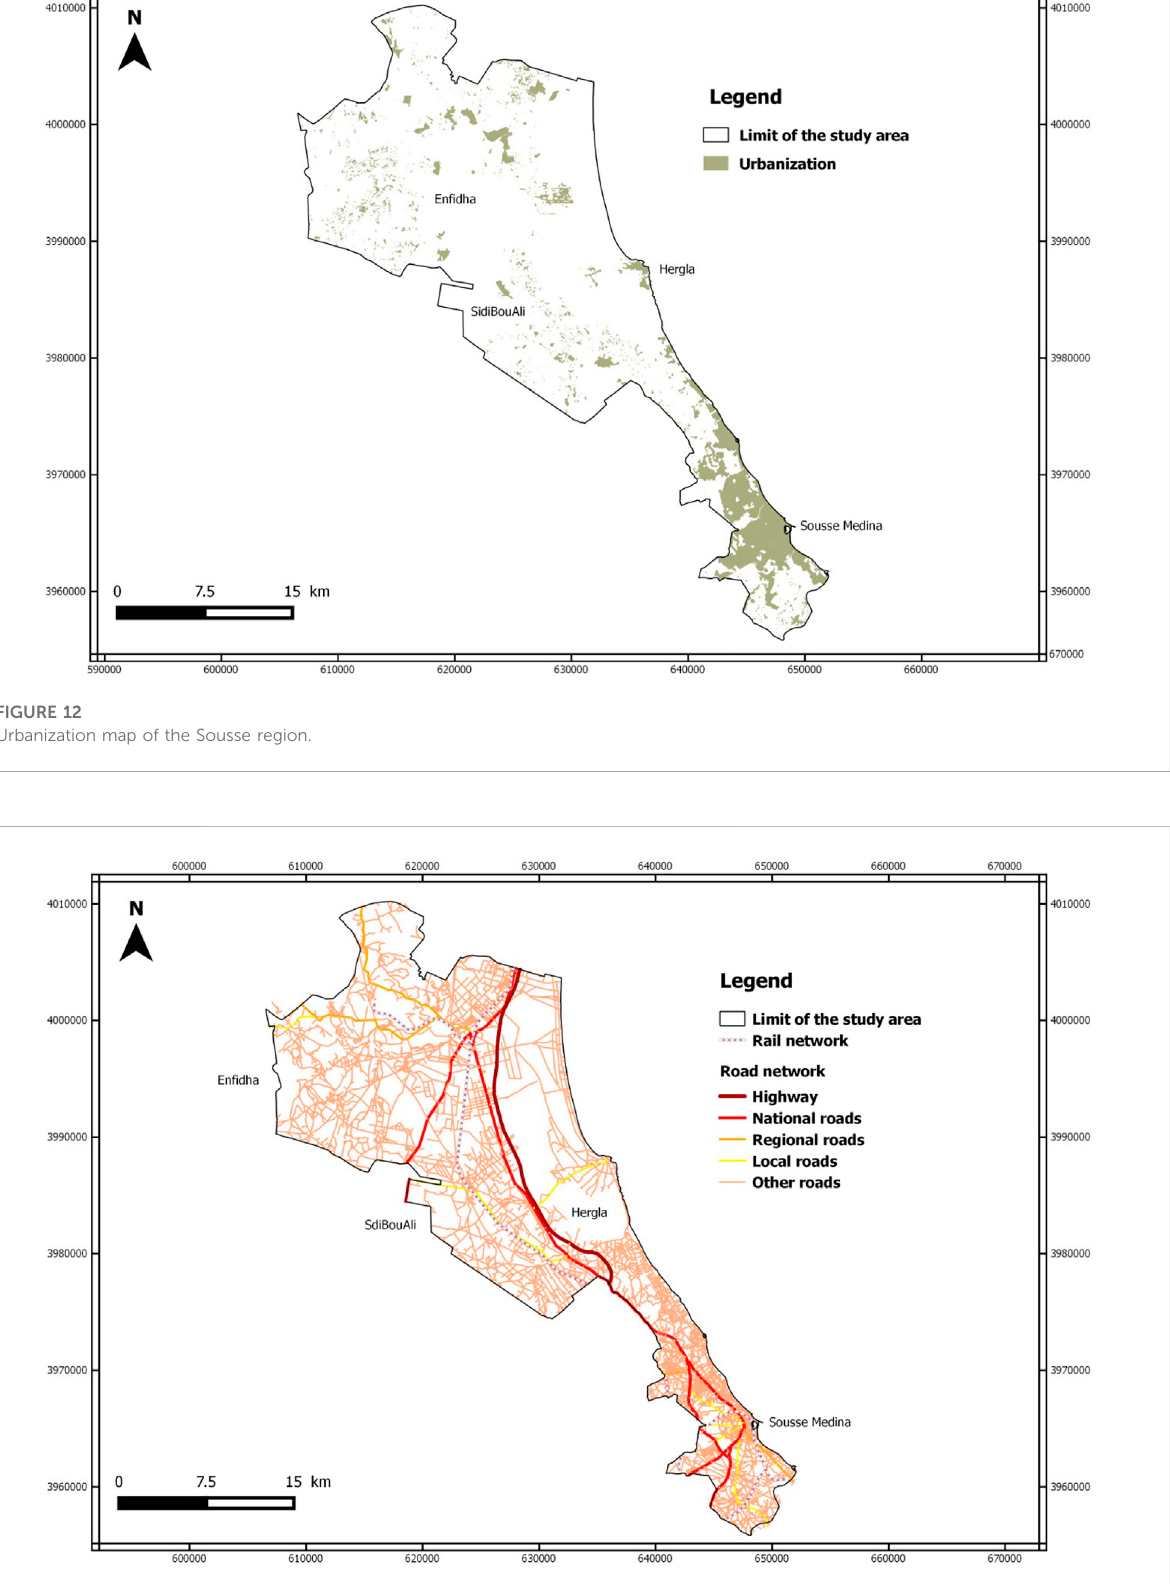
FIGURE 13 Terrestrial transport network of the Sousse